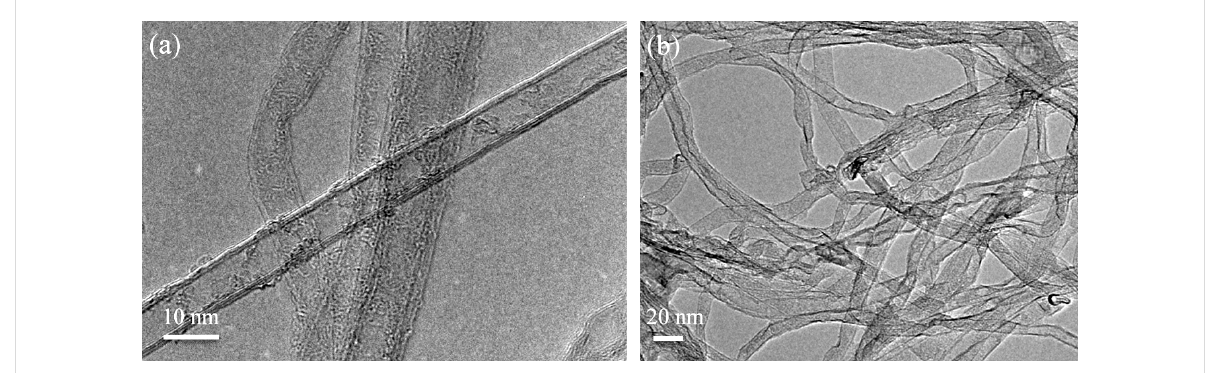
Figure 6: TEM overview of a) thin MWCNTs starting material and b) graphene nanoribbons after treatment.